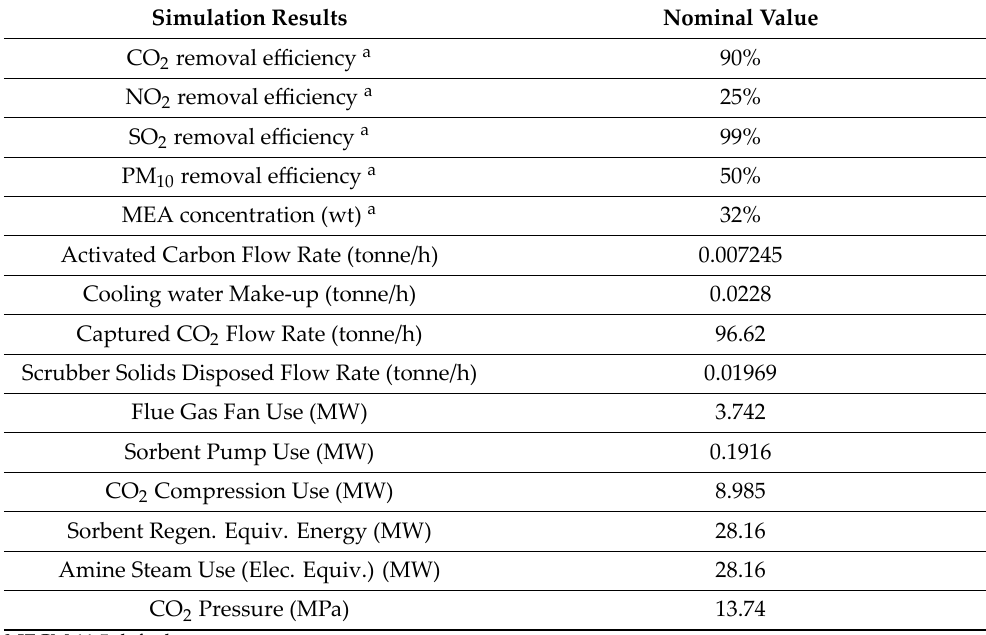
Table 5. Simulation results of the proposed CO 2 capture plant for the Hartha power